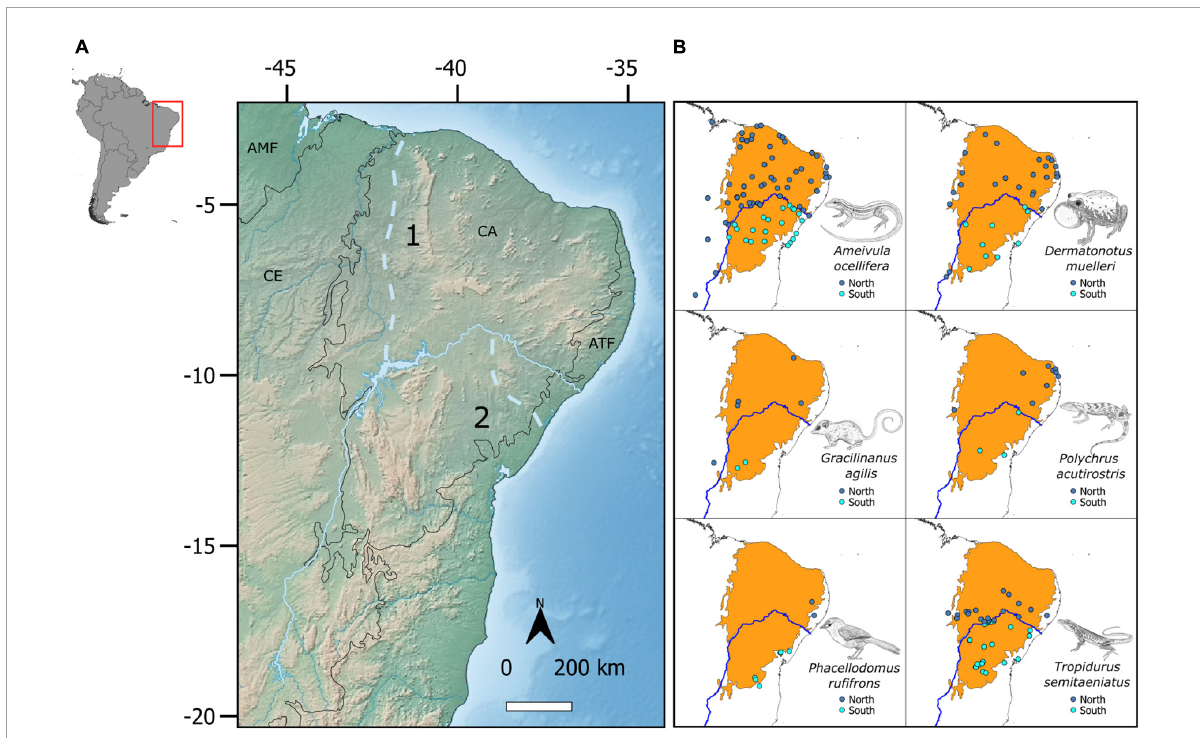
FIGURE1 (A) Extent of the Caatinga in Brazil, bisected by the São Francisco River in its current course (light blue continuous line) and paleocourse (light blue dotted line). 1—Older paleocourse before elbowing east; 2—More recent paleocourse south of modern course; CA, Caatinga; AMF, Amazonia; ATF, Atlantic Forest; CE, Cerrado. (B) The distribution of samples of six vertebrate species used to test the São Francisco River (blue line) Hypothesis in the